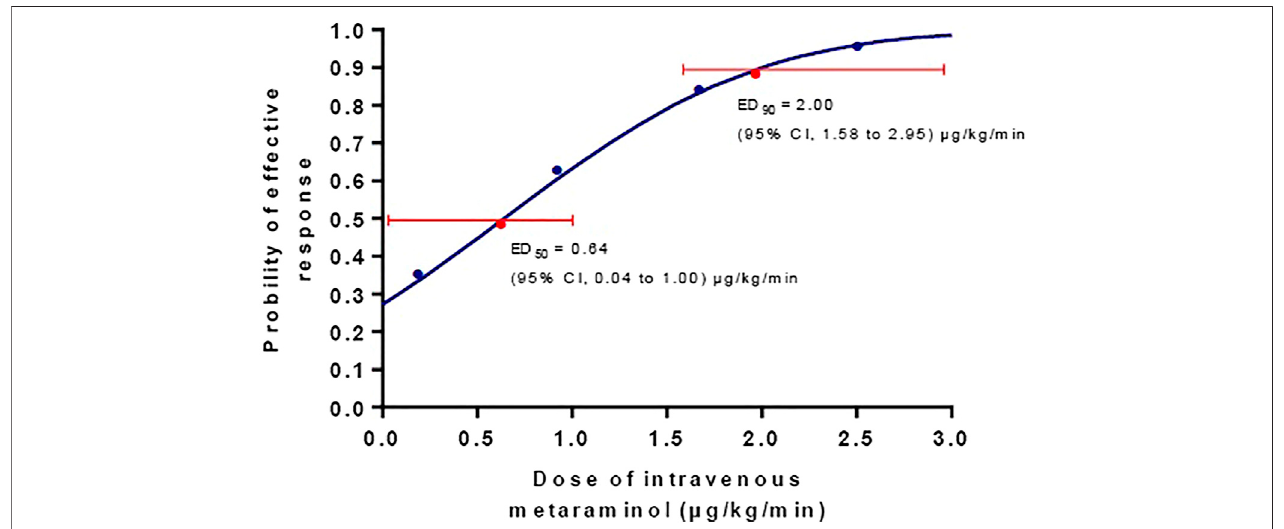
FIGURE2| The dose-responsecurve ofmetaraminol forpreventingspinal anesthesia-induced hypotension. TheED 50 and ED 90 values ofweight-based fi xed rate of metaraminol infusion were0.64 (95% CI, 0.04 – 1.00) μ g/kg/min and 2.00 (95% CI, 1.58 – 2.95) μ g/kg/min respectively.